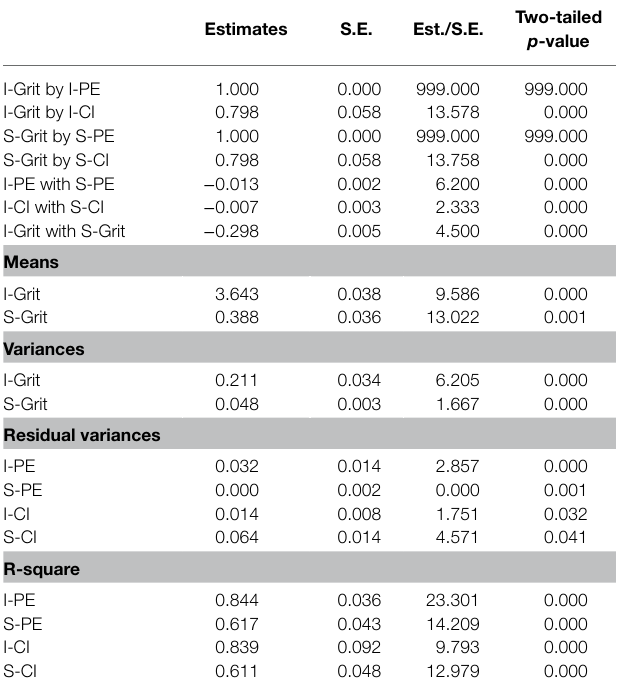
TABLE 3 | Parameter estimates for